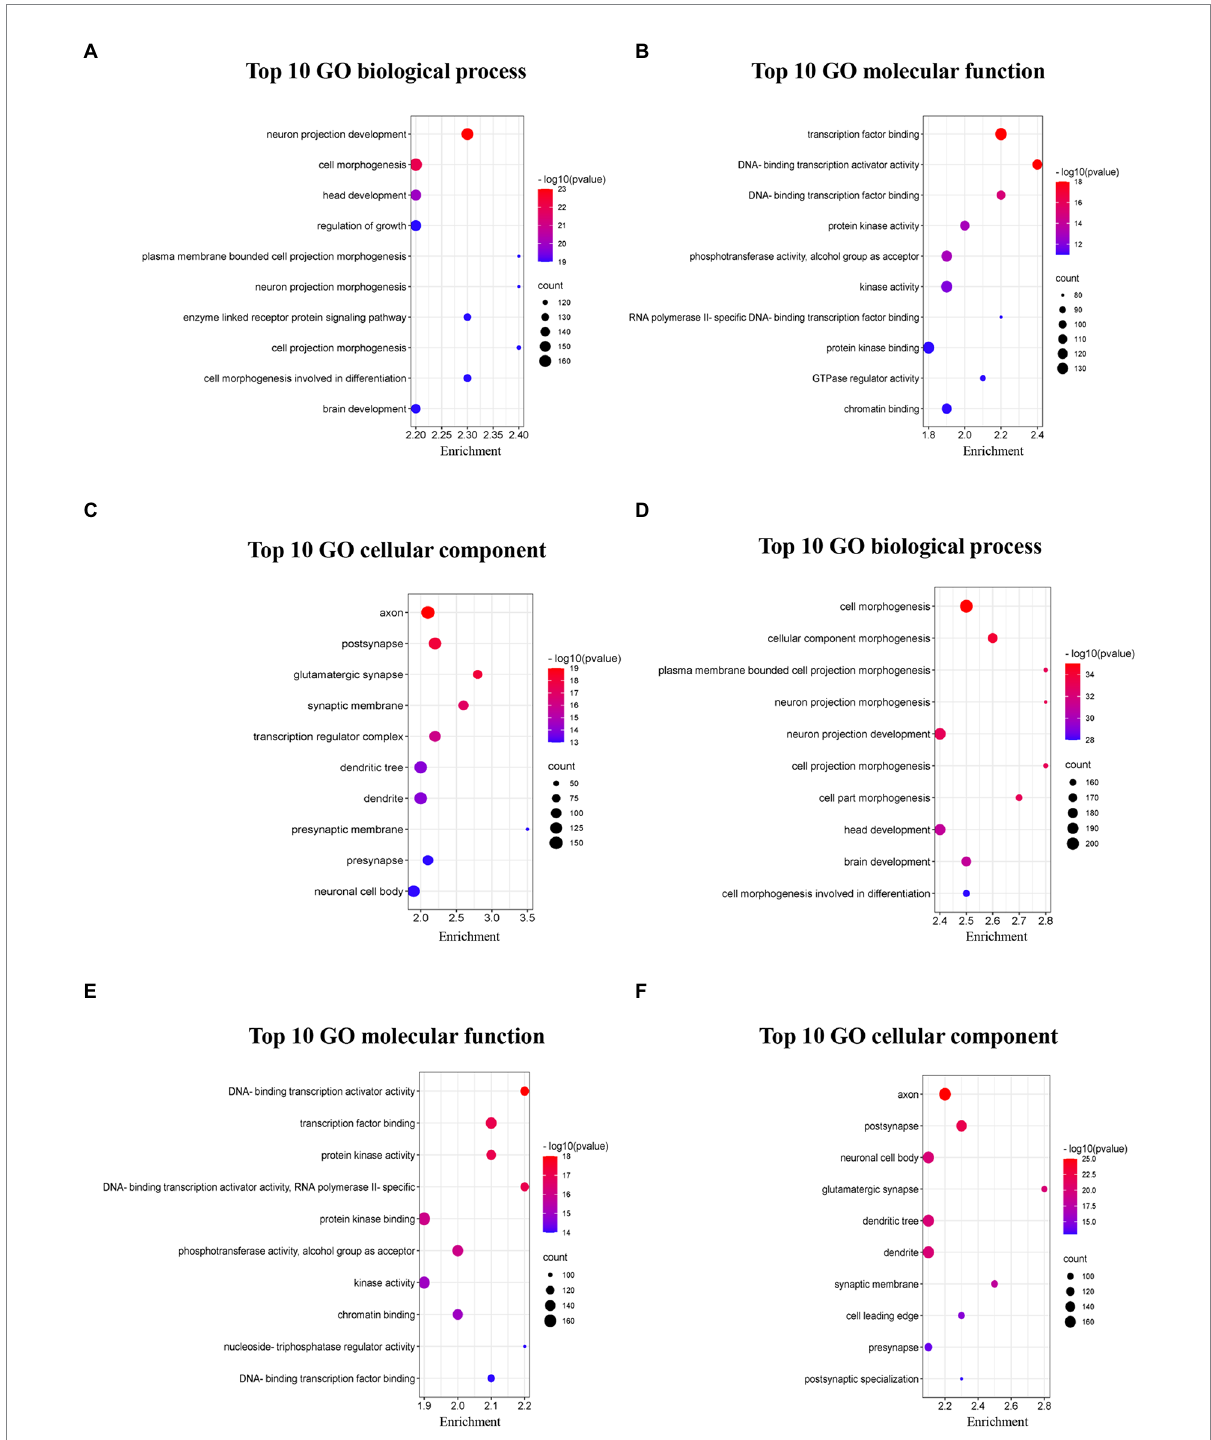
FIGURE 5 Top 10 GO pathways of dysregulated circRNAs in 5 × FAD mice. (A) Biological processes of upregulated circRNAs. (B) Molecular function of upregulated circRNAs. (C) Cellular component of upregulated circRNAs. (D) Biological processes of downregulated circRNAs. (E) Molecular function of downregulated circRNAs. (F) Cellular component of downregulated circRNAs. The bubble size represents the number of enriched genes, while the bubble color represents the significance of enrichment based on the corrected value of p